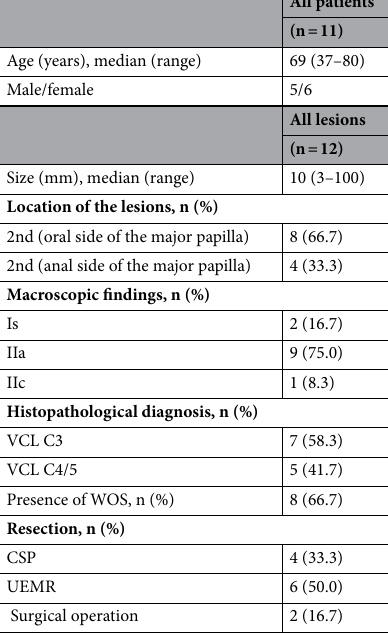
Table 1. Characteristics of the participants and lesions. VCL Vienna classification, CSP cold snare polypectomy, UEMR underwater endoscopic mucosal